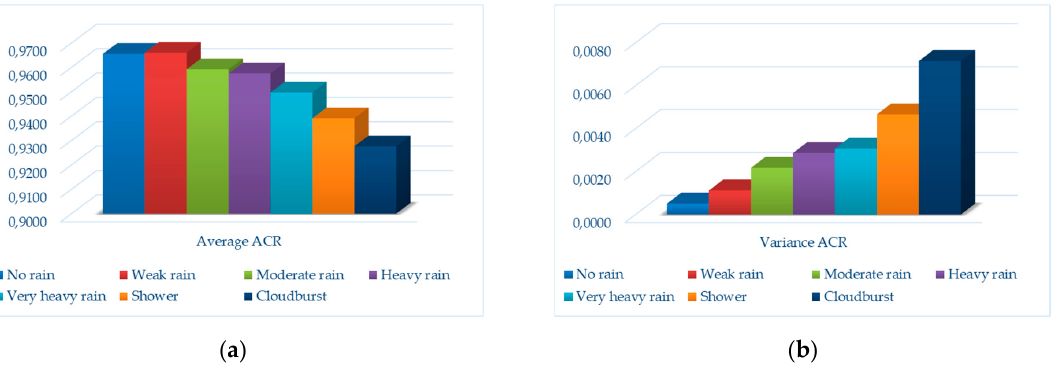
Figure 9. ZCR values for different rainfall classification levels: ( a ) average of ZCR values; ( b ) variance of ZCR values. Figure 10. ACR values for di ff erent rainfall classification level: ( a ) average of ACR values; ( b ) variance of ACR